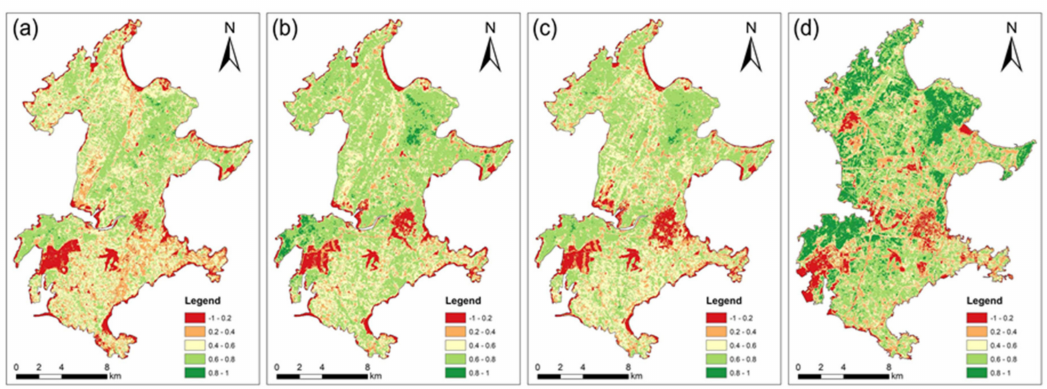
Figure 7. The maximum NDVI: ( a ) 1990, ( b ) 2000, ( c ) 2007, and ( d ) 2019 on Haitan